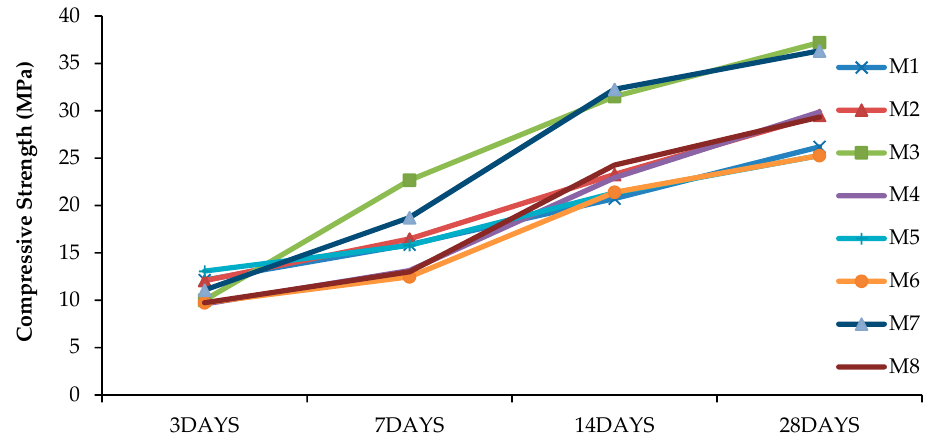
Figure 8. Results of compressive strength of blended cement mortar.